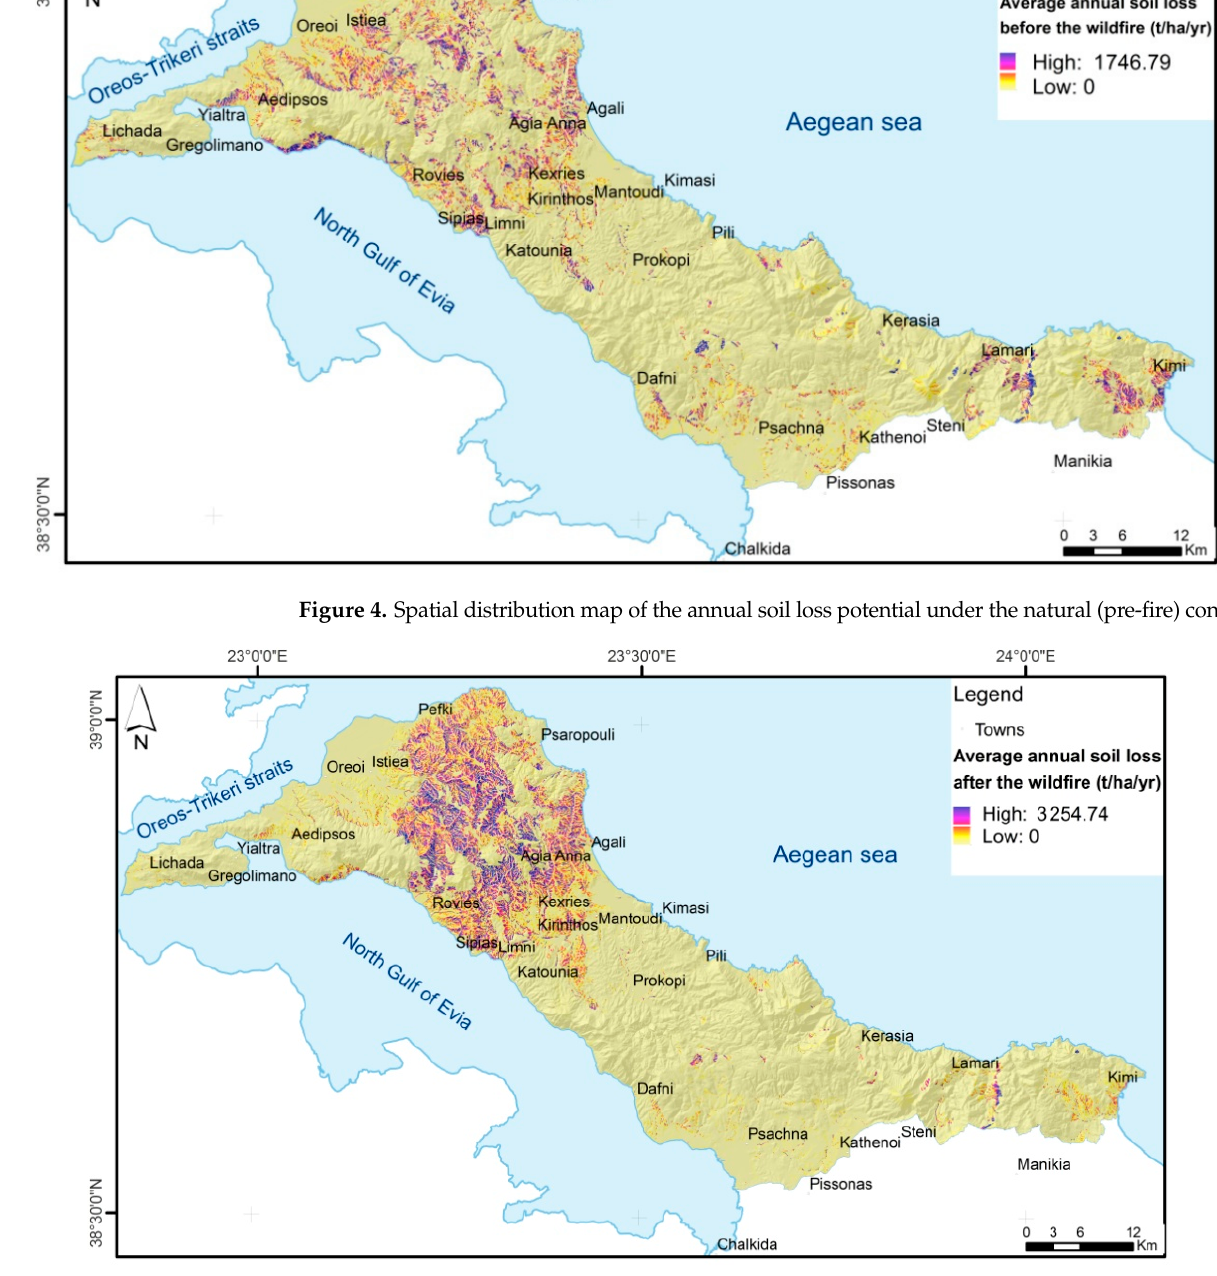
Figure 5. Spatial distribution map of the calculated annual soil loss potential under the post-fire condition.